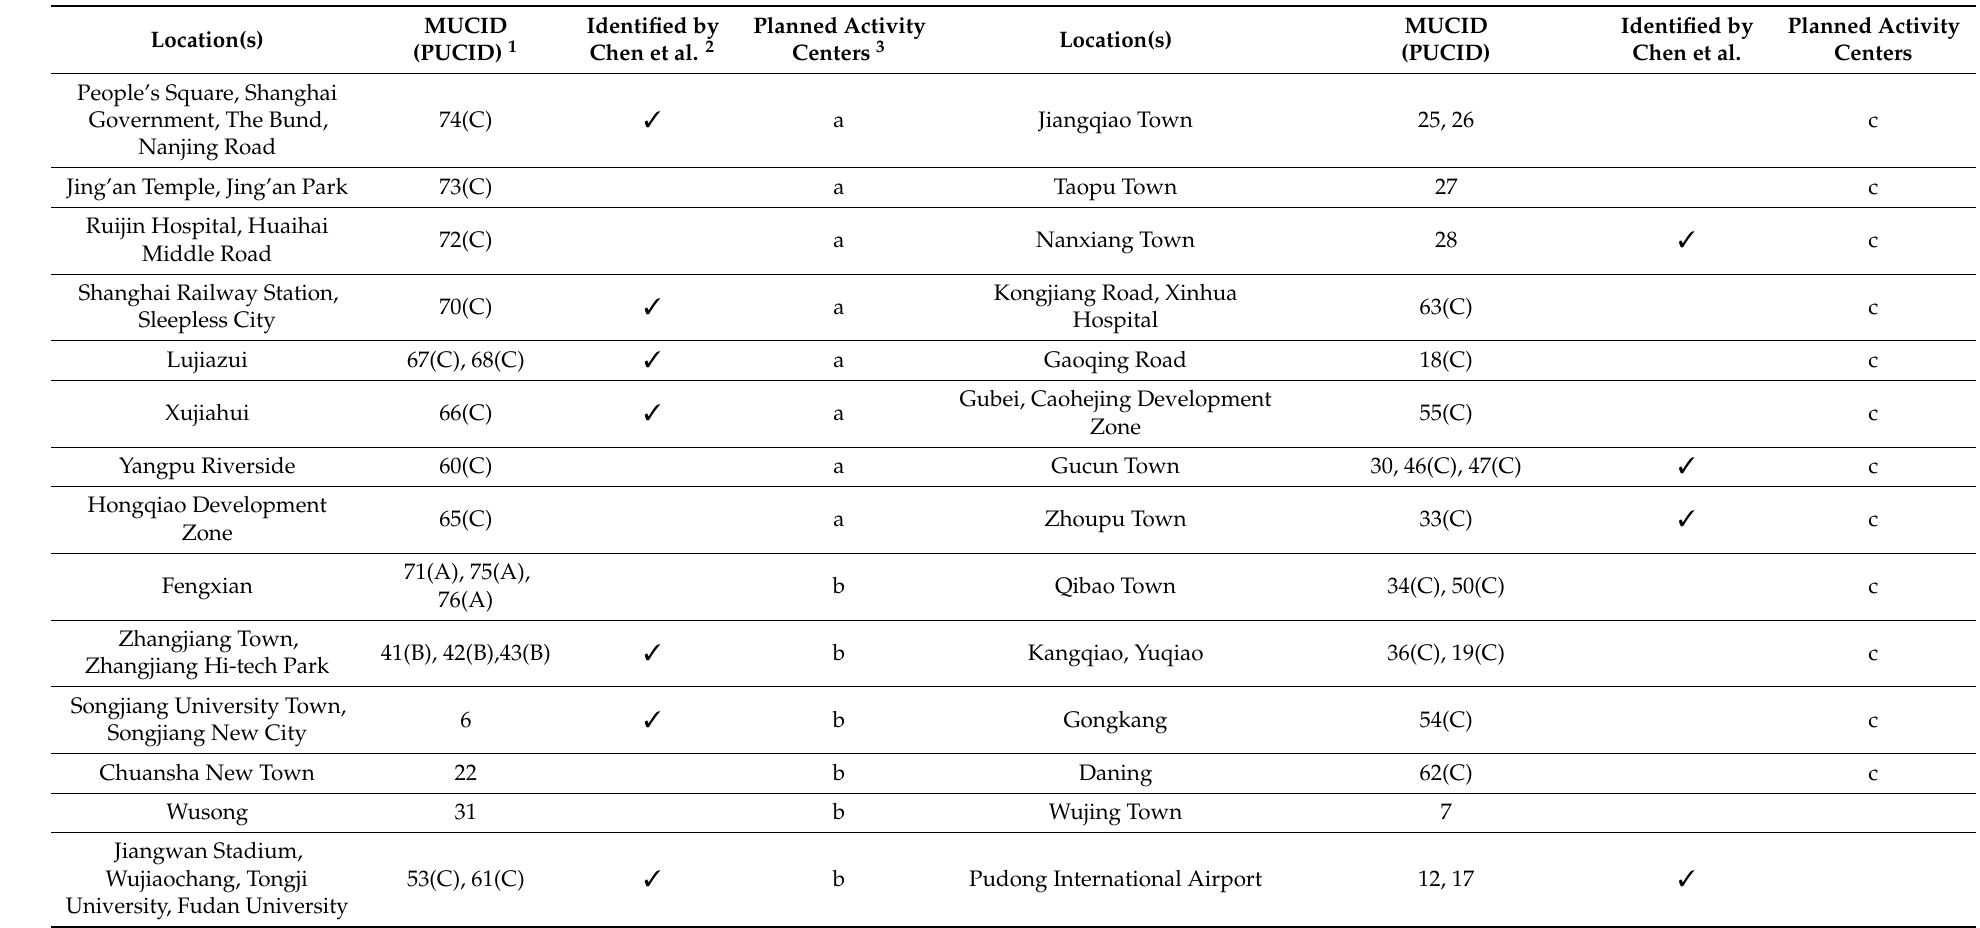
Table 3. Validation of urban